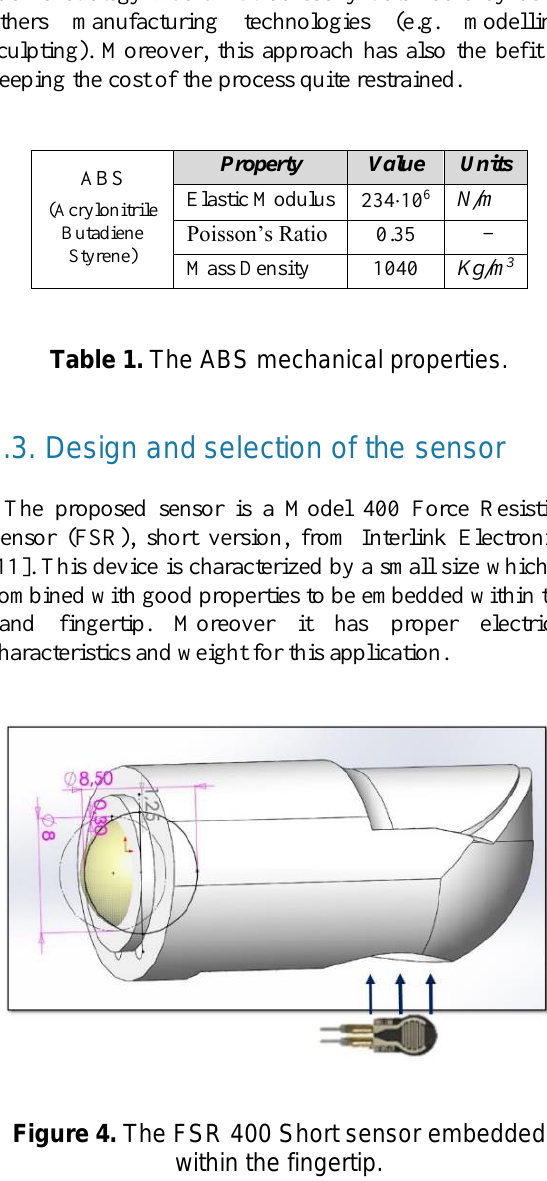
Figure 4. The FSR 400 Short sensor embedded within the